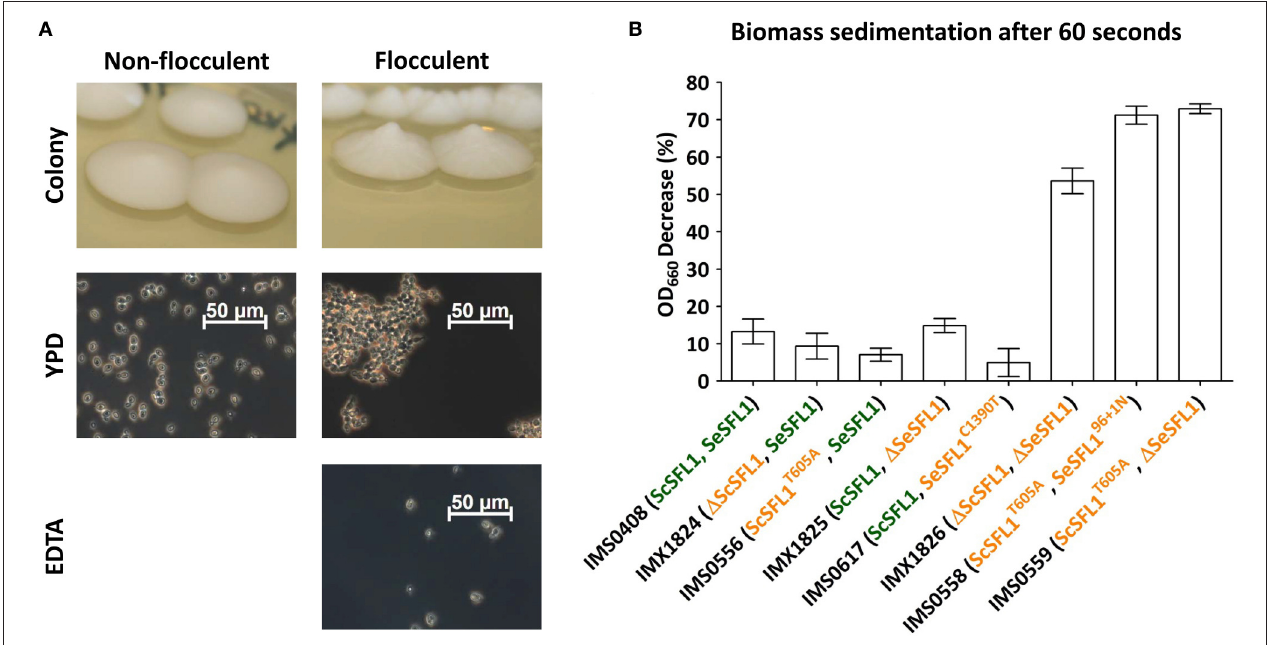
FIGURE 3 | Mutations in ScSFL1 and SeSFL1 correlate with flocculation in evolved isolates and reverse engineered strains. (A) Colony morphology and phase-contrast microscopy images (100x) of YPD-grown cell suspensions of the non-evolved, non-flocculent strain (IMS0408), and of a typical flocculent evolved isolate (IMS0558). Resuspension in 50mM EDTA (pH 7.0) eliminated flocculation. (B) Biomass sedimentation of evolved isolates and engineered strains with mutations in SeSFL1 and/or ScSFL1 . Triplicate cultures of all strains were grown on YPD and sedimentation was measured as the decrease in OD 660 right underneath the meniscus of a stationary cell suspensions 60s after the suspension had been